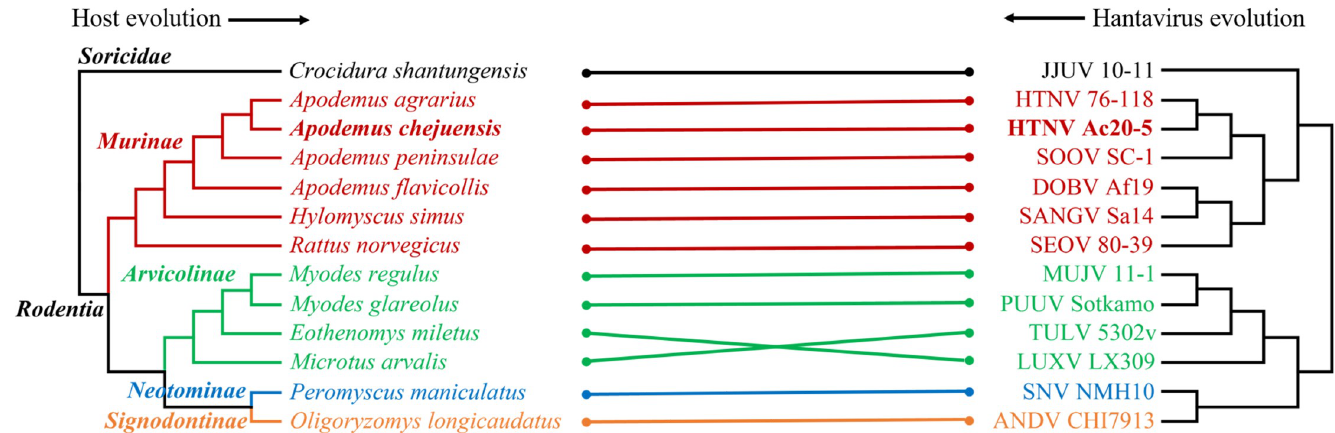
Fig 5. Tanglegram comparing the phylogenies between hantaviruses and their reservoir hosts in Rodentia. Tanglegram was generated using the R package, using consensus maximum likelihood topologies based on the nucleotide sequences of the hantaviral M segment (right panel) with mitochondrial DNA cytochrome b gene sequences of the reservoir host species (left panel). Letters for taxa are shown in red for Murinae , green for Arvicolinae , blue for Signodontinae , orange for Neotominae , black for Soricidae in left panel. Apodemus chejuensis -borne HTNV (Ac20-5) is shown in bold lettering in each panel. The host species and viruses accession number followed up; reservoir hosts Crocidura shantungensis (HQ993053), A . agrarius (MN205319), A . chejuensis (MW219775), A . peninsulae (AB073811), A . flavicollis (JF819967), Hylomyscus simus (DQ212188), Rattus norvegicus (AB355903), Myodes regulus (NC_016427), Myodes glareolus (AF119272), Eothenomys miletus (AY426686), Microtus arvalis (EU439459), Peromyscus maniculatus (AF119261), Oligoryzomys longicaudatus (AF346566), hantavirus strains JJUV 10–11 (NC_034404), HTNV 76–118 (M14627), HTNV Ac20-5 (MW219763), SOOV SC-1 (AY675353), DOBV Af19 (NC_005234), SANGV Sa14 (NC_034516), SEOV